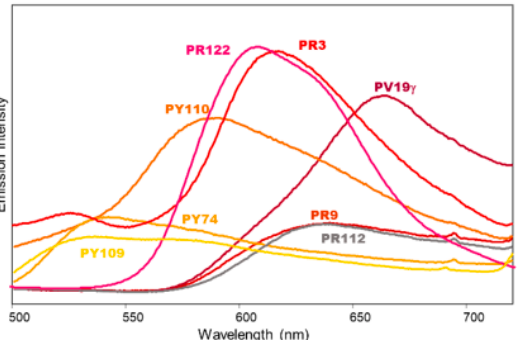
Figure 5. Emission spectra ( λ exc 365 nm) of painting layers shown in Figure 3c and containing red, yellow, and violet synthetic organic pigments dispersed in linseed oil (PR3, PR122, PY109, PY110, and PV19) or acrylic binder (PY74, PR9, and PR112). For PR122 the band intensity was reduced by a factor of 10 for better comparison with the other pigments’ spectra. The highest intensity value reported in the figure is about 1/5 of the maximum value reported in Figure 4.